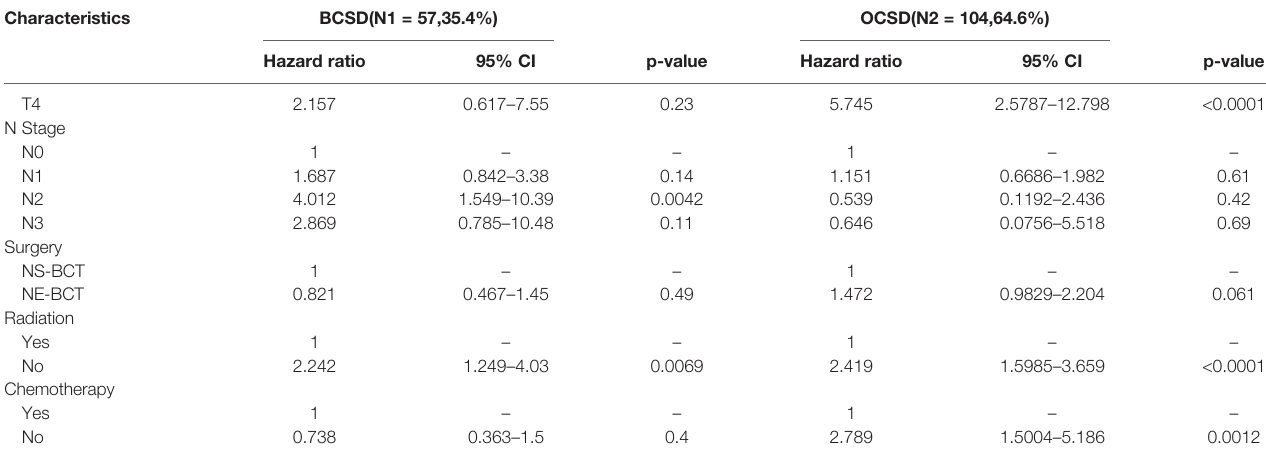
Supplementary Figure 1 | Kaplan – Meier survival analysis for NE-BCT and NS- BCT female breast cancer patients in the original cohort. (A) Overall survival curves in NE-BCT group and NS-BCT group. (B) Breast cancer speci fi c survival curves in NE-BCT group and NS-BCT